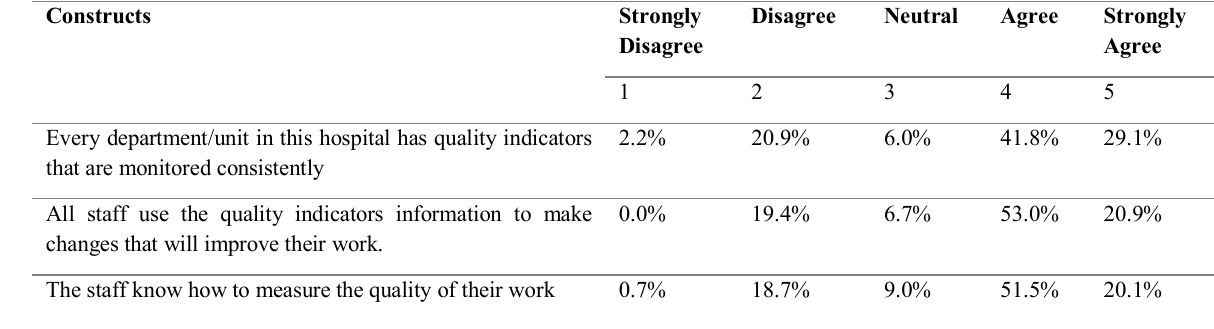
Table 6: Frequency distribution for quality